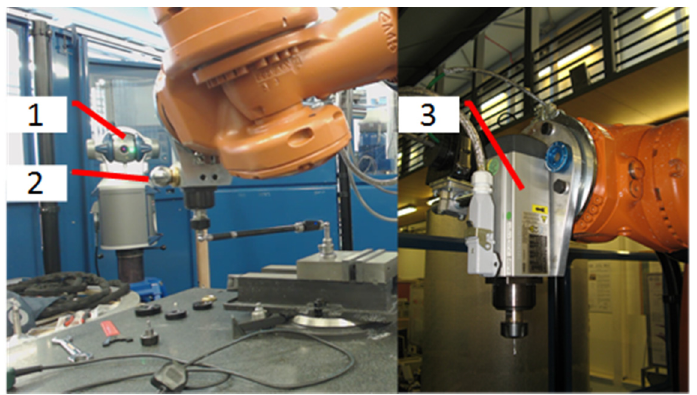
Figure 2. Laser tracker and spindle. ( 1 ) FARO laser tracker; ( 2 ) laser tracker spherically mounted reflector (SMR); ( 3 ) machining spindle.